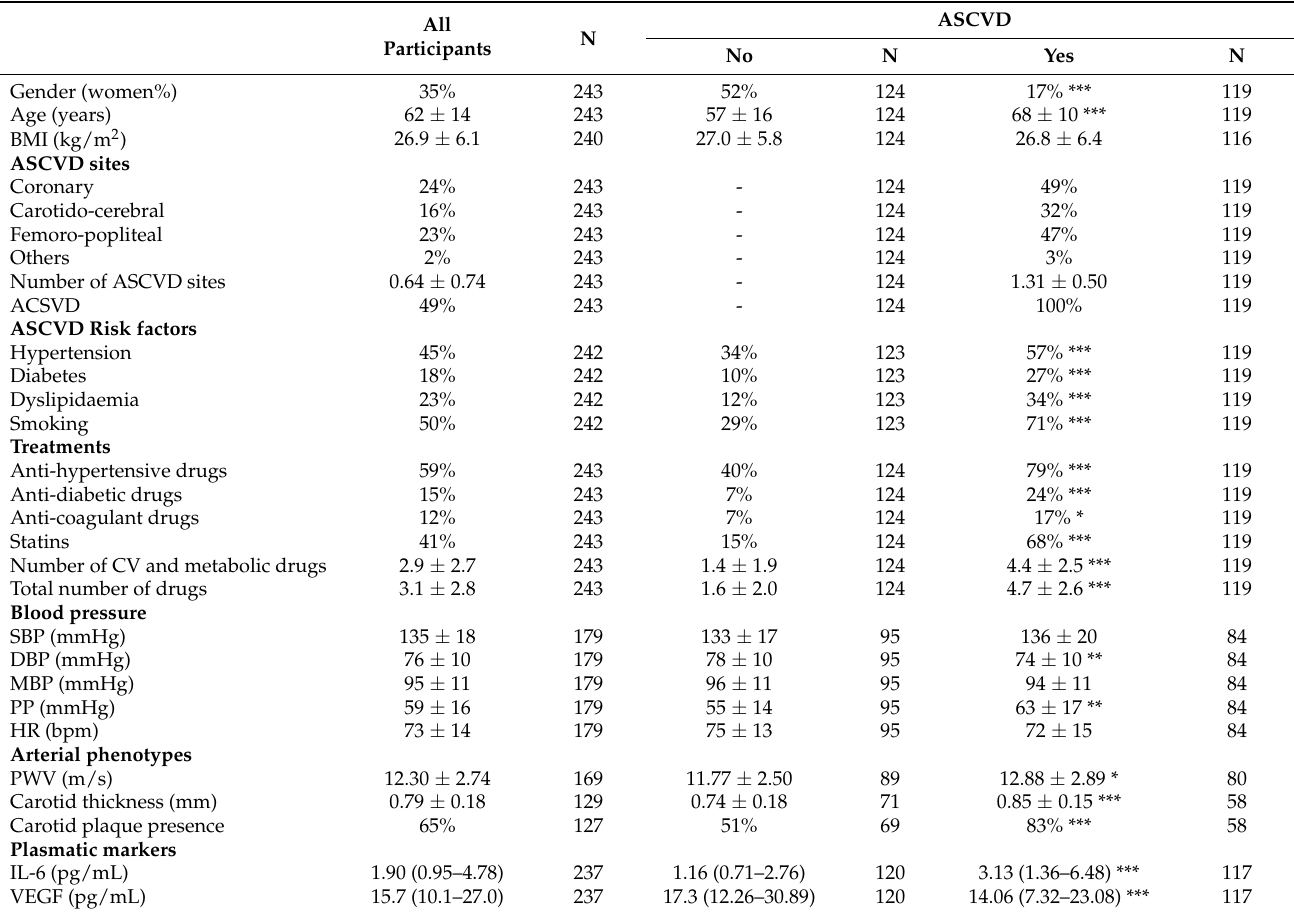
Table 1. Clinical characteristics of participants. Data are presented as mean ± SD, median (IQR), or percentages